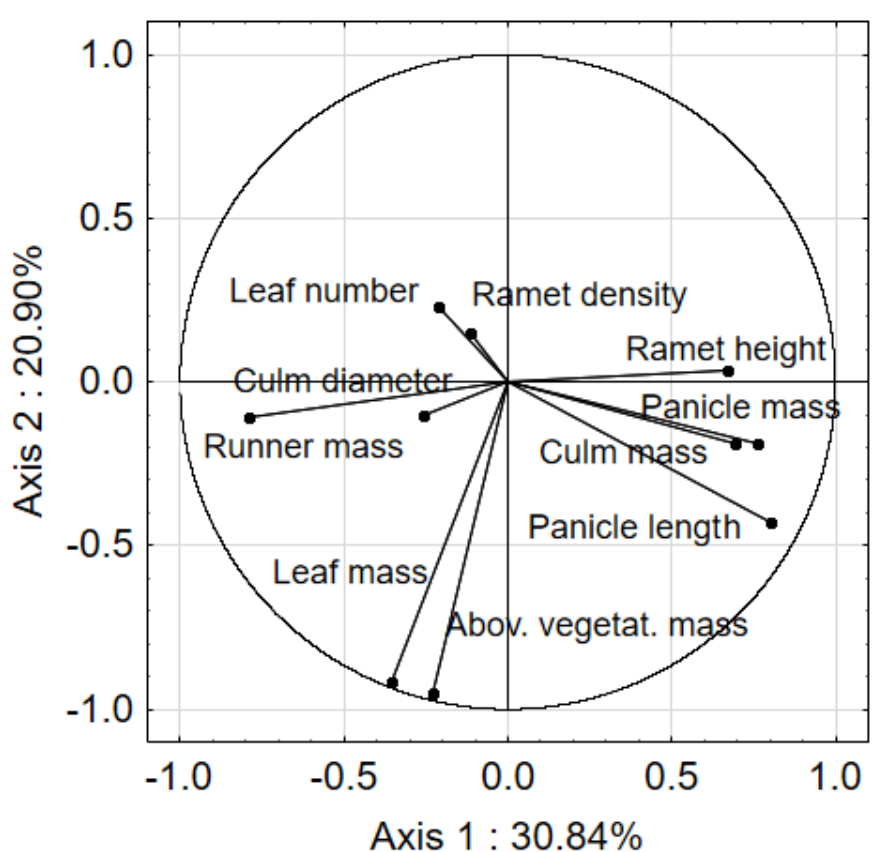
Figure 1. Ordination of biometric parameters of Calamagrostis epigejos in the space of two PCA axes. Table 2. Results of multiple regression analysis (stepwise progressive method) of Calamagrostis epigejos biometric parameters and the total number of species. The analyses were conducted for standardized and ln